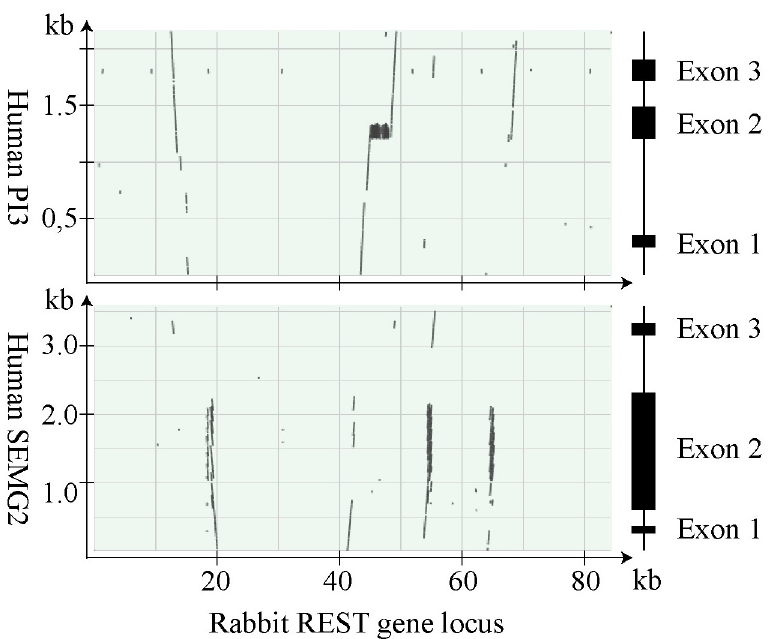
Fig 6. Dotplot showing sequence homology with SEMG2 and PI3 at the rabbit REST gene locus. The computer program BLAST was used to align rabbit genomic sequences, located between SLP and WFDC5 at the REST gene locus, and the nucleotide sequences of human SEMG2 and PI3 . The lines with boxes to the right illustrate the genes with boxes depicting the location of exons.